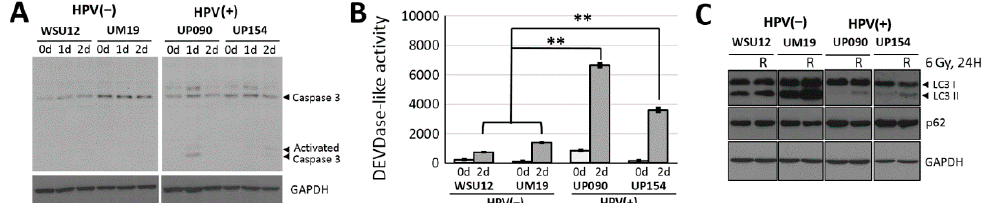
Figure 1. Radiosensitive human papillomavirus (HPV)-positive head and neck squamous cell carcinoma (HNSCC) cells were associated with apoptosis and radioresistant HPV-negative HNSCC with high autophagic flux. ( A ) Immunoblot of caspase 3 and ( B ) DEVDase activity assay at indicated day after irradiation at 6 Gy. (** p < 0.01) ( C ) Immunoblot of LC3 and p62 in control or one day after irradiation at 6 Gy.